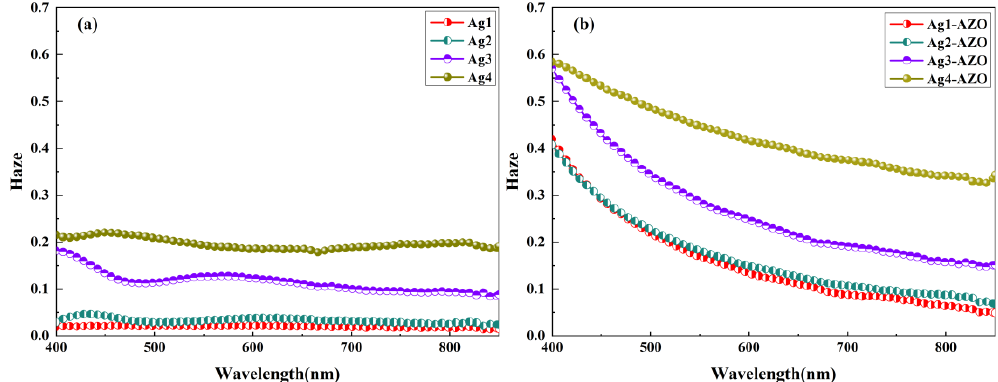
Figure 4. Haze spectra of ( a ) Ag NWs films on the AZO SL and ( b ) Ag NWs/AZO NRs composite films.